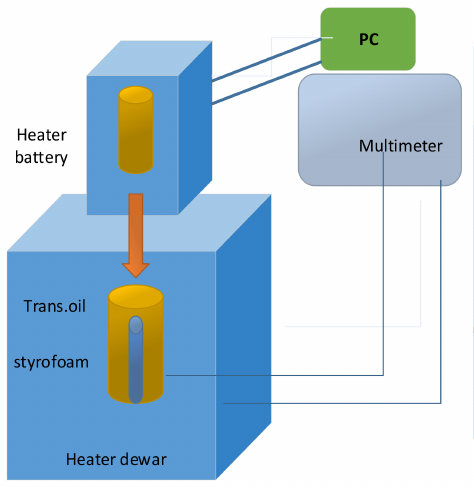
Figure 9. Specific heat capacity setup (method two—adiabatic calorimetry)